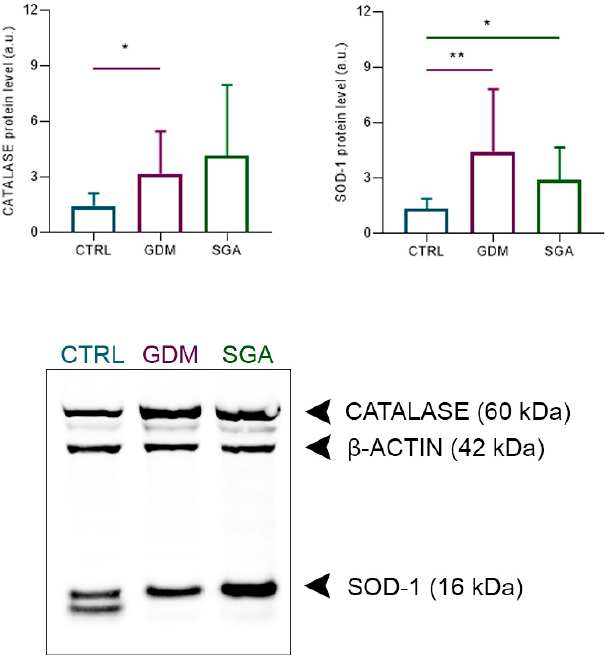
Figure 1. Relative levels of antioxidant enzymes in the control and pathological placenta slices. In the graphs, bars indicate the CATALASE (60 kDa)/ β -actin (42 kDa) ratio and SOD-1 (16 kDa)/ β -actin (42 kDa) ratio densitometric analysis ± SD of twelve independent replicates ( n = 12). Asterisks indicate significant differences (* = p < 0.05; ** = p < 0.01) when comparing the pathologies to the control group. CTRL: control group (blue), GDM: gestational diabetes mellitus (purple), SGA: small-for-gestational-age (green).